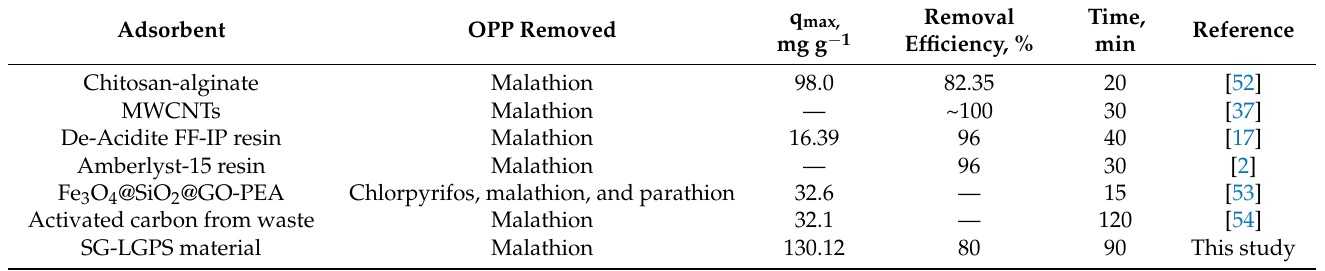
Table 3. The maximum adsorption capacity and the removal efficiency of malathion by different adsorbents.